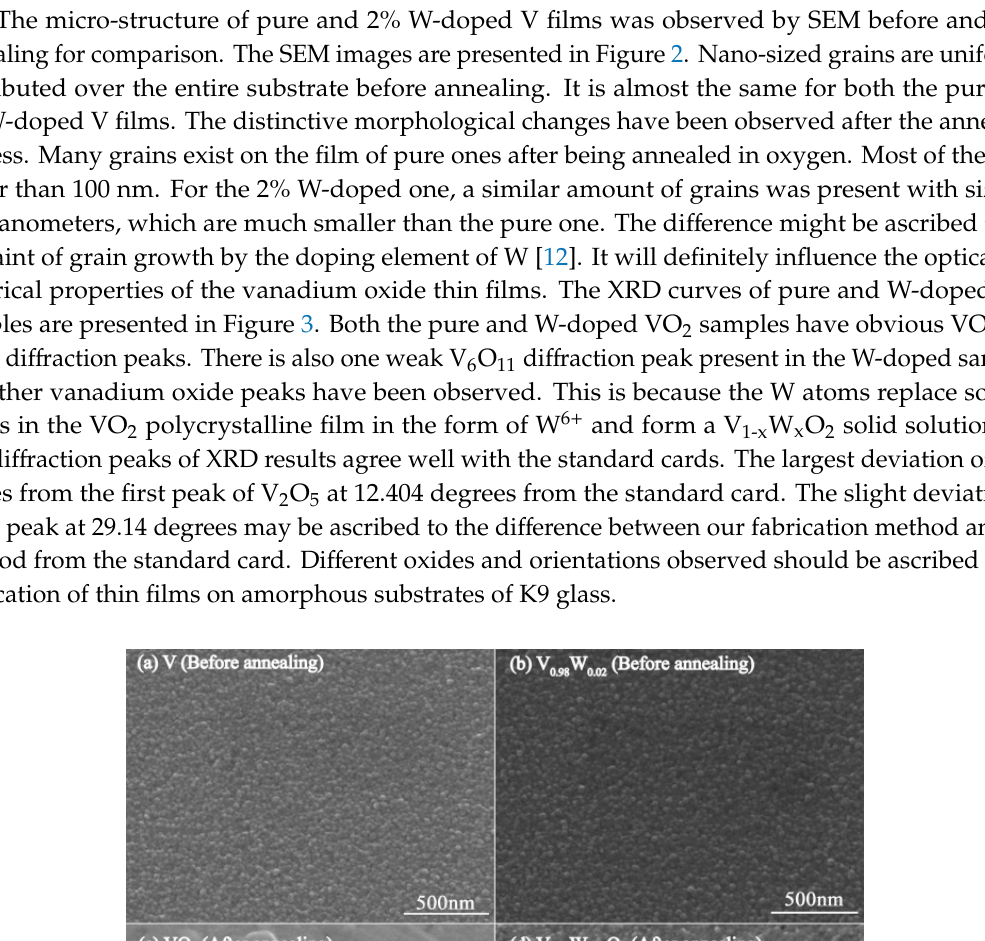
Figure 3. XRD curves of pure and W-doped VO 2 films fabricated on amorphous K9 glass substrates. The films were sputtered with the power of 500 W: 0 W and 0 W: 500 W for the pure and 2% W-doped